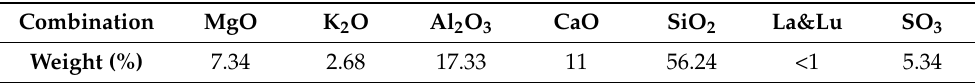
Table 4. Elements forming particle samples resulting from XRF analysis.